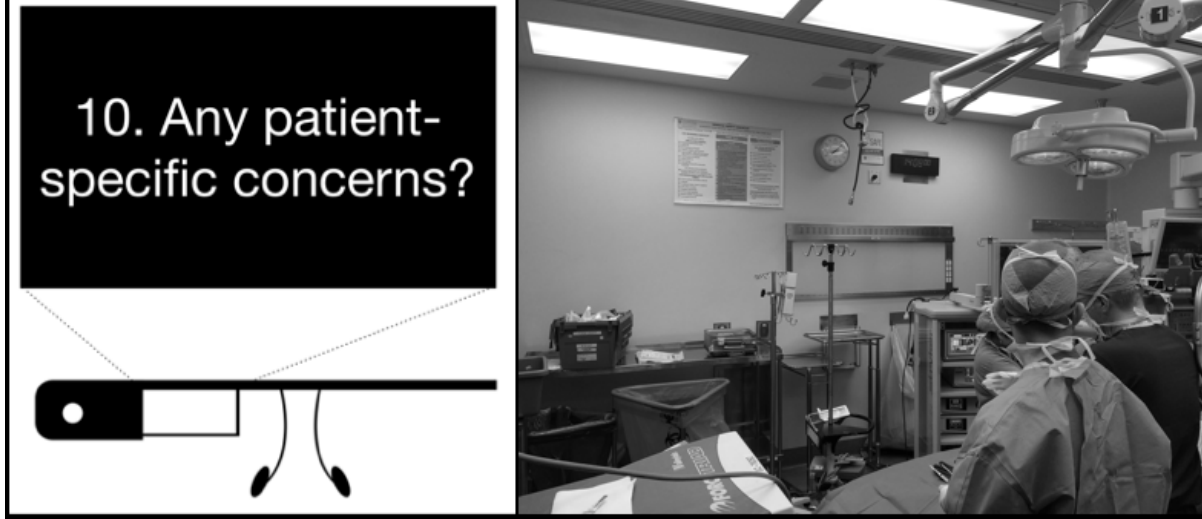
Figure 2. Checklist items displayed in the smart glasses app versus wall poster.